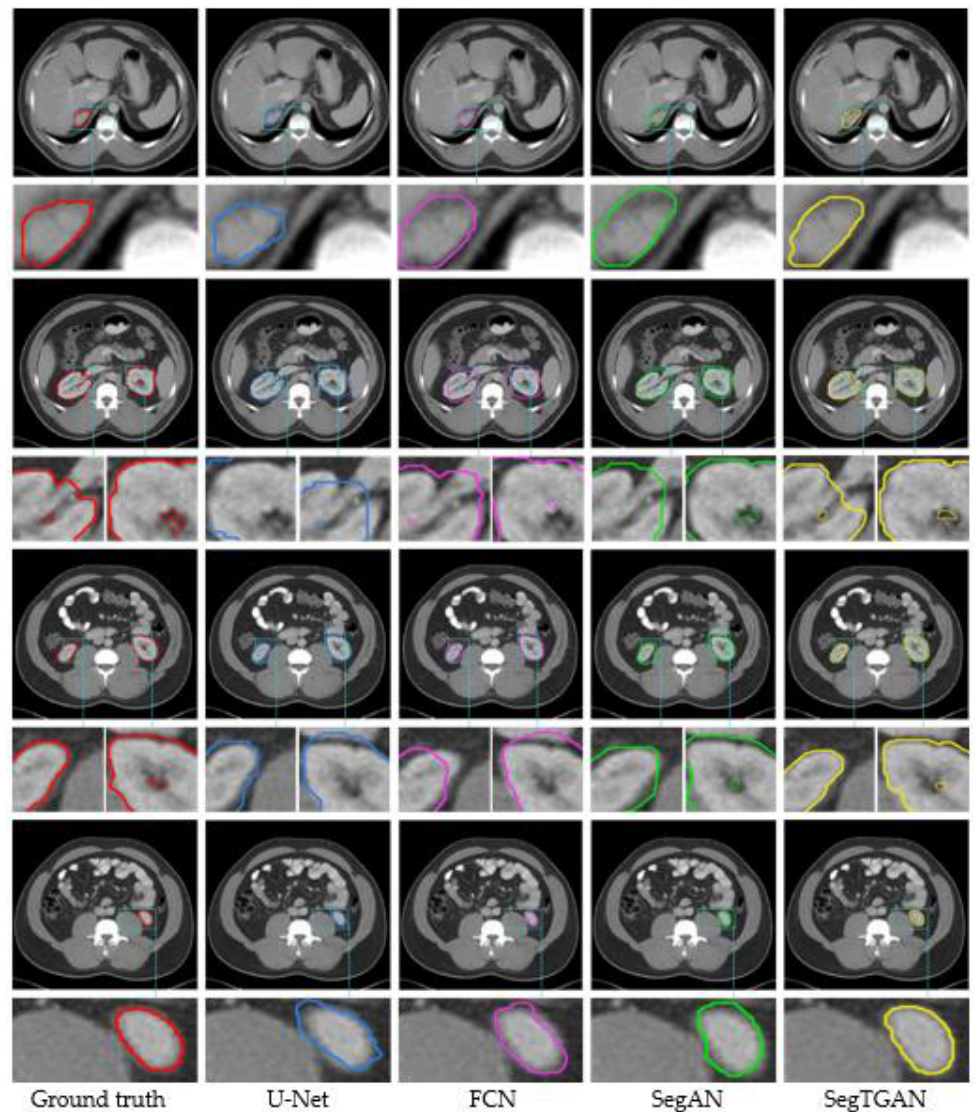
Figure 5. The segmentation results of each network in different slices on the Kits19 dataset. For the same CT slice, each row displays the kidney segmentation results from various networks. The truth labels are displayed in the first column, and the kidney contours produced using U-Net, FCN, SegAN, and SegTGAN, respectively, are displayed in columns 2 through 5, with local zooms below. The segmented kidney’s outline is the area that the colored curve has encircled.